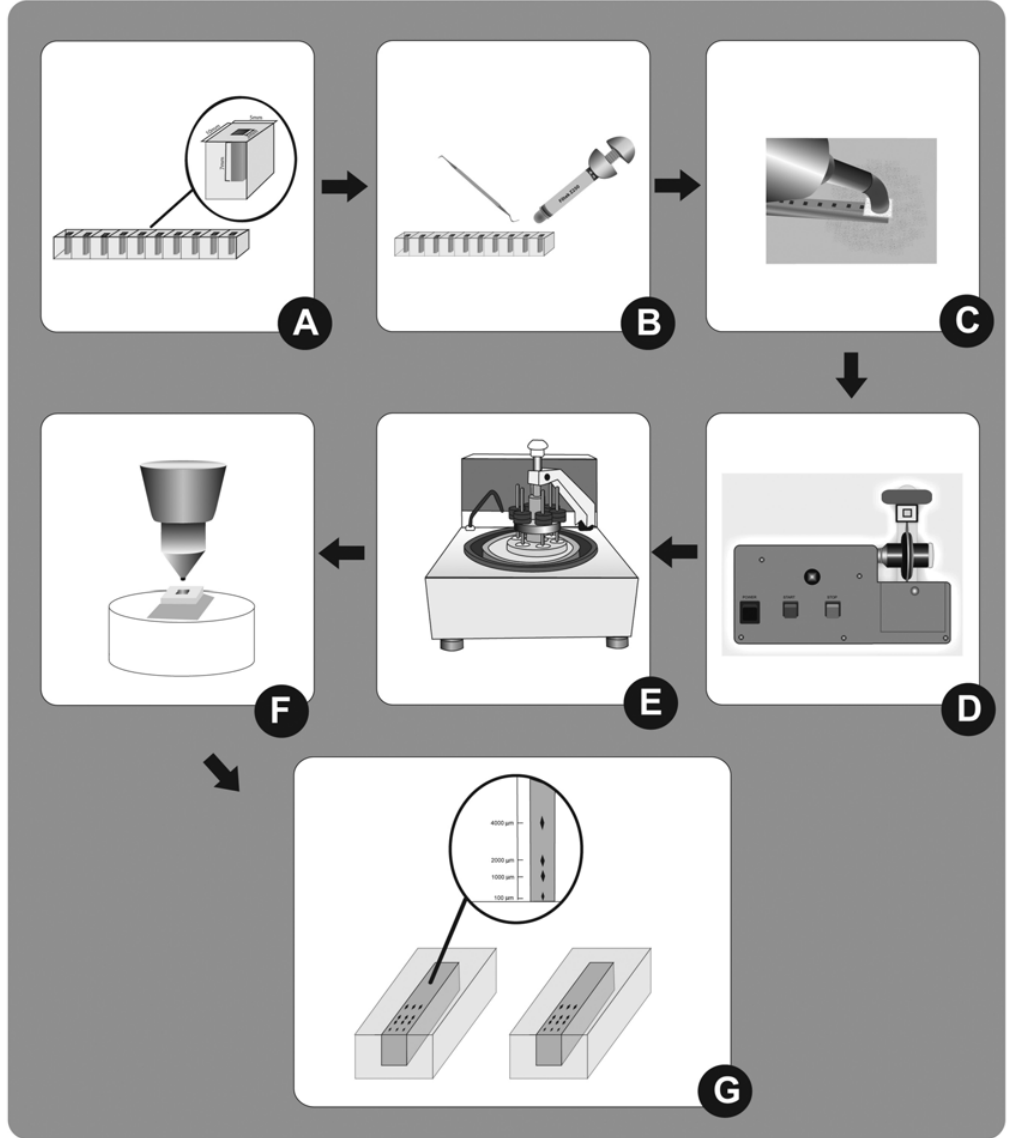
FIGURE 1- Schematic representation of experimental phase. a) Polyvinyl chloride (PVC) plates with cylindrical cavities (3.0 mm x 7.0 mm) prepared to do the specimens; b) Insertion of composite resin in the plates. c) Curing methods; d) Sectioning of the specimen in the central region. e) Finishing and polishing of the specimen surface; f) Microhardness tester; g) Schematic illustration of the polyvinyl chloride (PVC) plates, showing the microhardness indentations at different depths from the surface of the composite